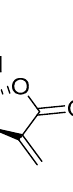
Figure 3. Structure of arglabin ( 2 ).